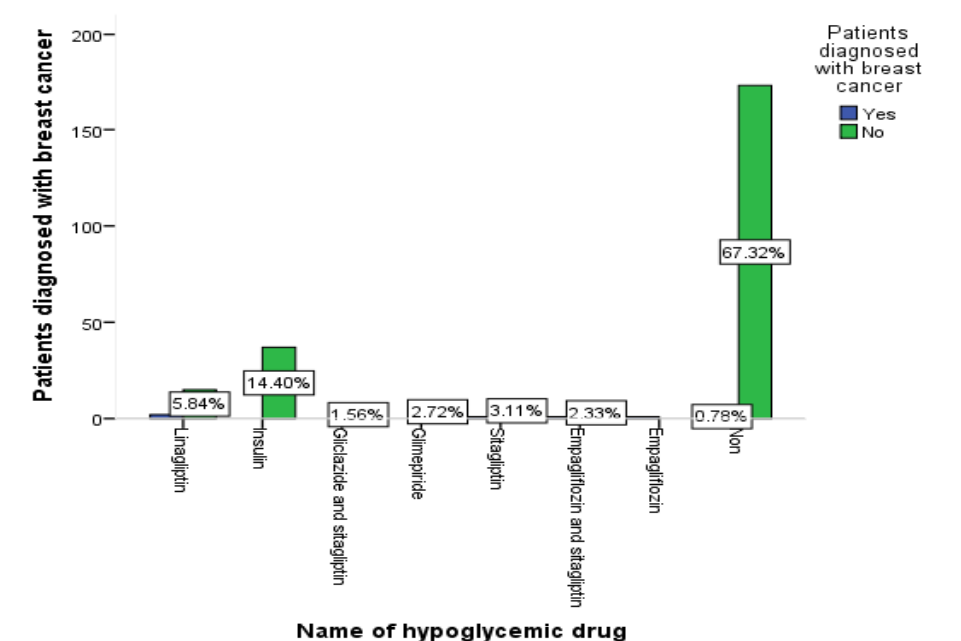
Figure 5. Frequency percentage distribution of relationship between medication group and patient diagnosis of breast cancer ( p value= 0.049).